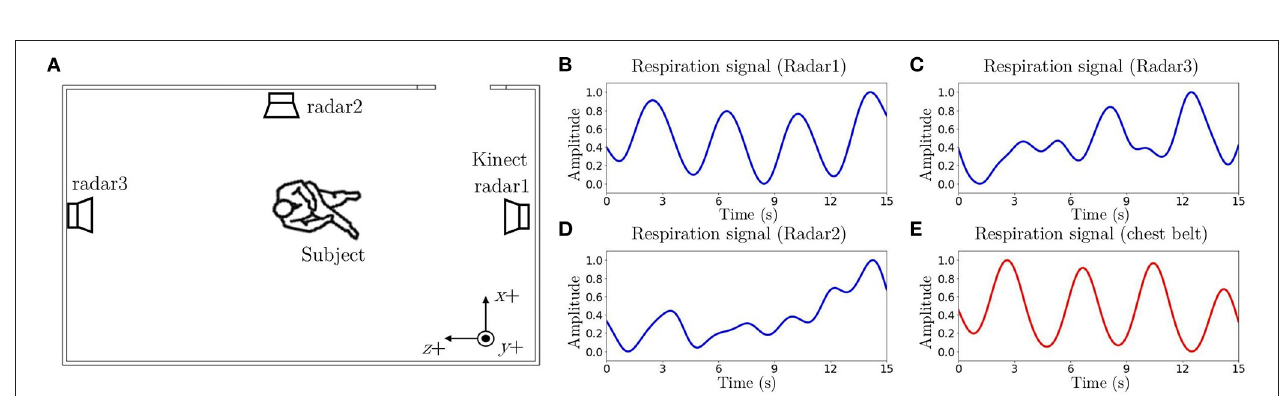
FIGURE 4 | (A) The location of the devices and their coordinates in the reference frame. (B) The method to determine if a subject is within radar detection area (black dash line: radar detection area). (C) Radar selection method based on subject’s orientation.